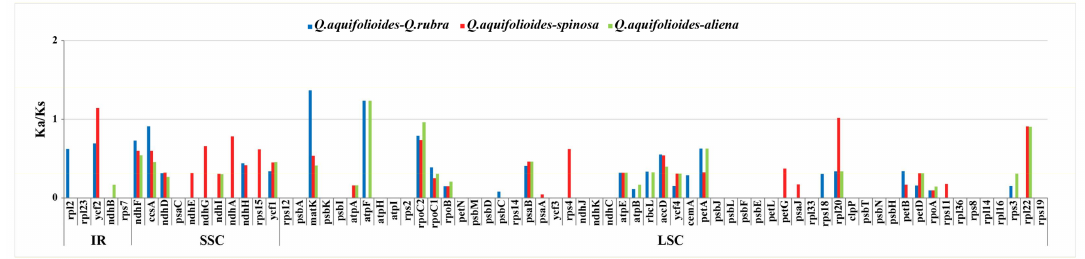
Figure 8. Ka/Ks ratios for protein-coding genes from Q. rubra , Q. spinosa , and Q. aliena chloroplast genome in comparison with Q. aquifolioides